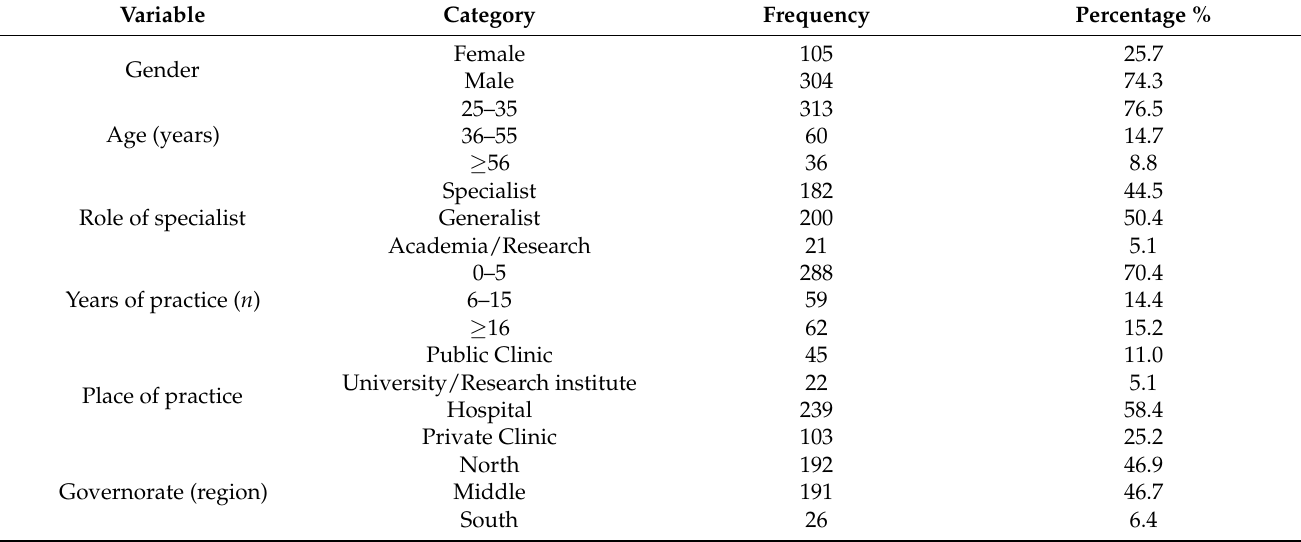
Table 1. Sociodemographic characteristics ( n =